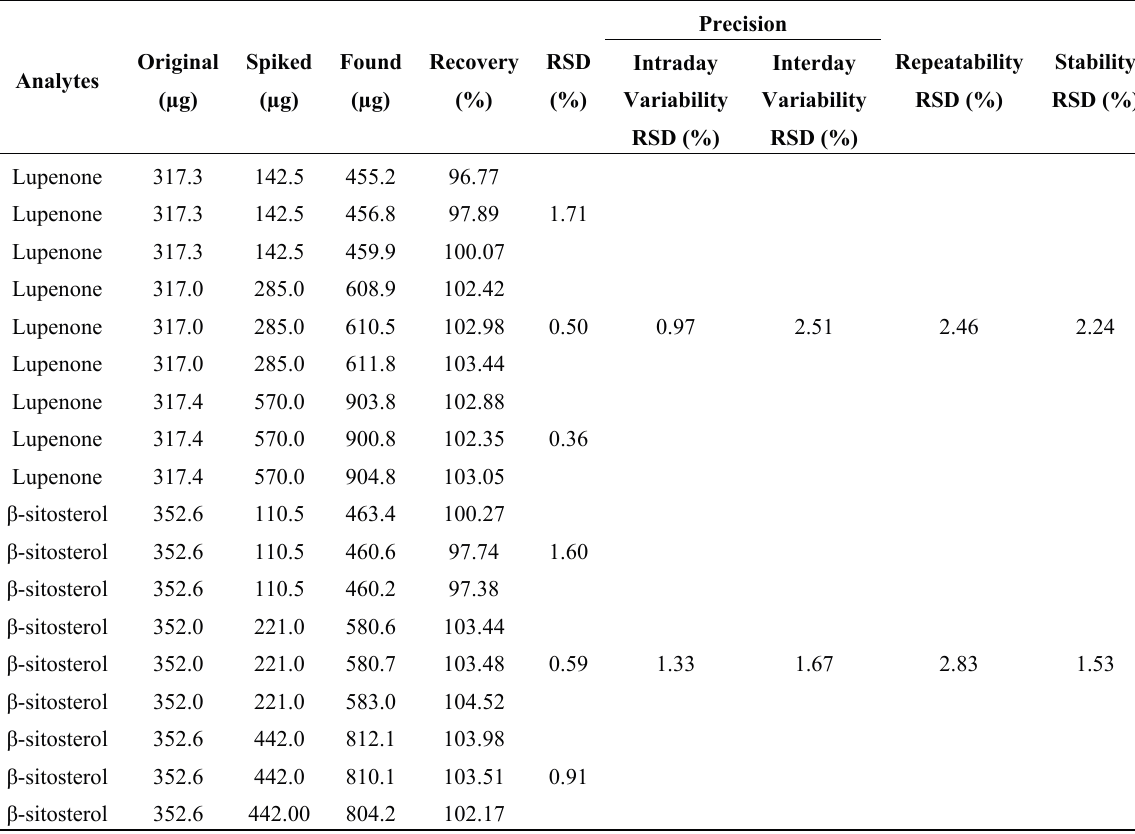
Table 3. Precision, Repeatability, Stability, and Recovery of lupenone and β -sitosterol.